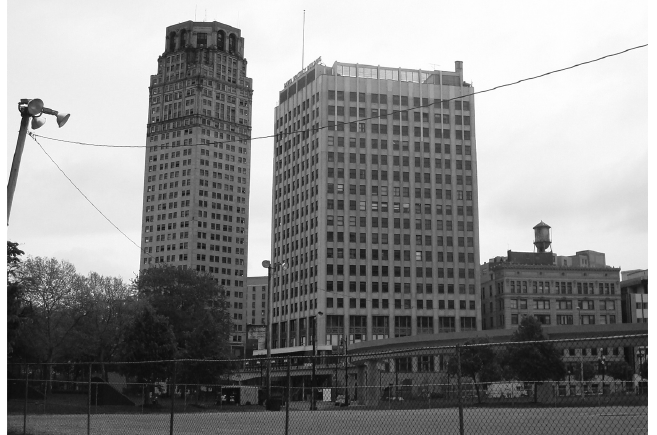
Figure 3. Remnants of structures from old Detroit. (© 2011 Yuemin Jin, all rights reserved, used by